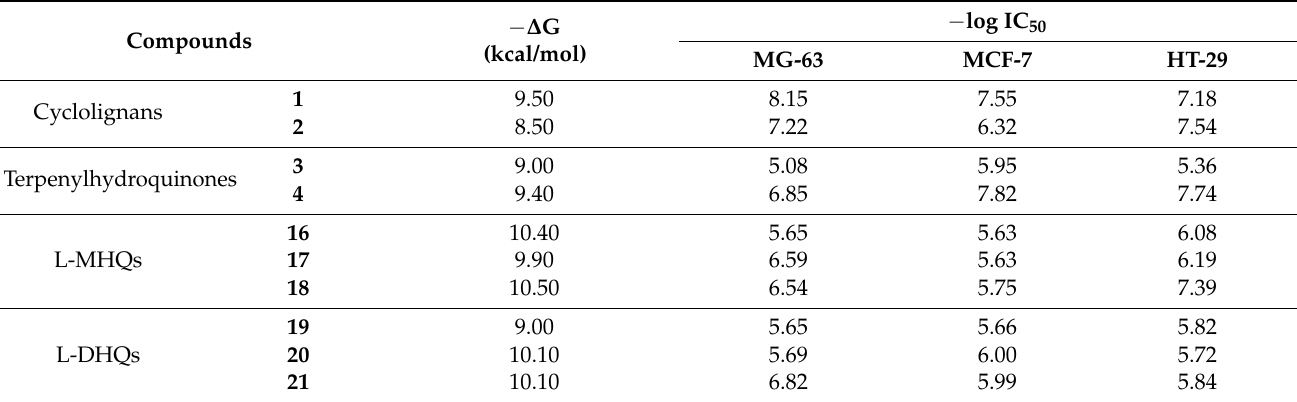
Table 2. Docking energies ( − ∆ G, kcal/mol) calculated for the interaction with tubulin, IC 50 cytotoxic values expressed as − log IC 50 for precursors and both series of